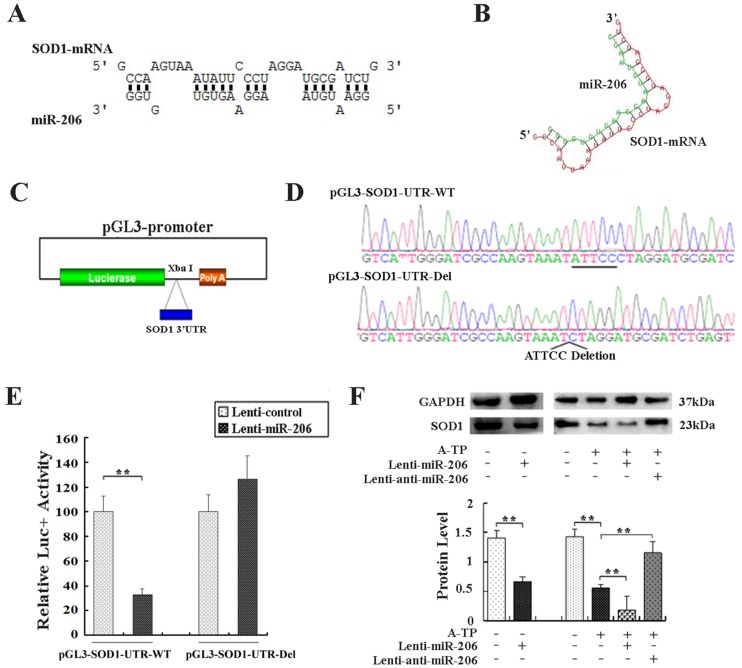
SOD1 was a direct target of miR-206.(A) Putative miR-206-binding sequences in the 3’UTR of SOD1 mRNA, identified by RNAhybrid 2.2. (B) The predicted miR-206-SOD1 binding structure, identified by RNAhybrid 2.2. (C) Schematic diagram of constructed vectors. The 3’UTR region of SOD1 was cloned downstream of the luciferase reporter gene (pGL3-promoter vector). (D) The sequence of the luciferase vector in pGL3-SOD1-UTR-WT and pGL3-SOD1-UTR-Del. (E) Primary canine myocardial cells were transfected with Firefly luciferase expression vectors with pGL3-SOD1-UTR. Luciferase activity was assayed 24 h after transfection. The Firefly luciferase activity of each sample was normalized to Renilla luciferase activity. The normalized luciferase activity of the cells transfected with the control lentivirus was set as 100% relative luciferase activity. The column graphs show the means of at least three independent experiments performed in duplicate. (F) Tissues of the LSFPs were collected in each group. SOD1, and internal standard GAPDH protein levels were detected as above. Western blot bands were normalized to GAPDH. **P < 0.01.